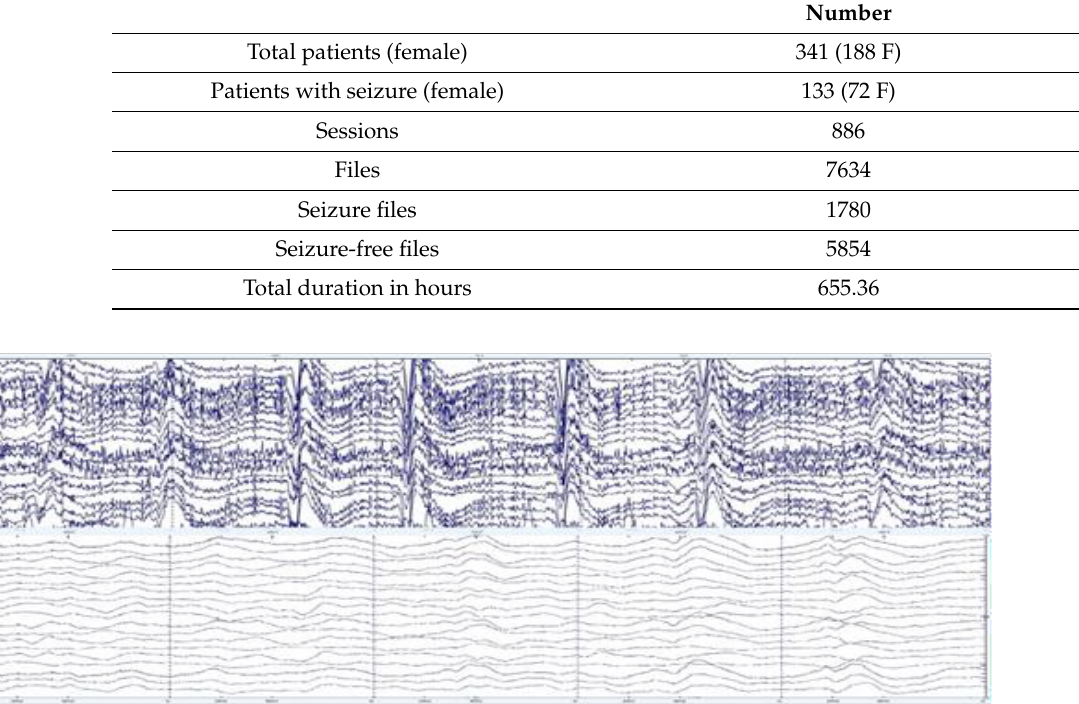
Figure 1. ( A ) An example of raw EEG including seizure epochs. ( B ) An example of normal EEG— seizure-free